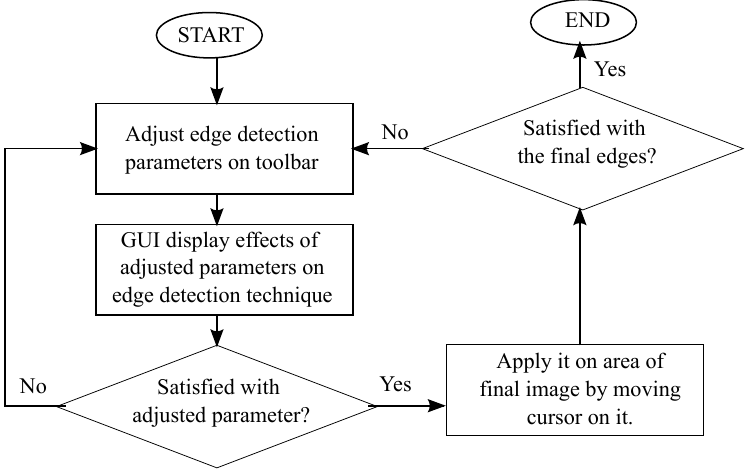
Figure 2. Flowchart of